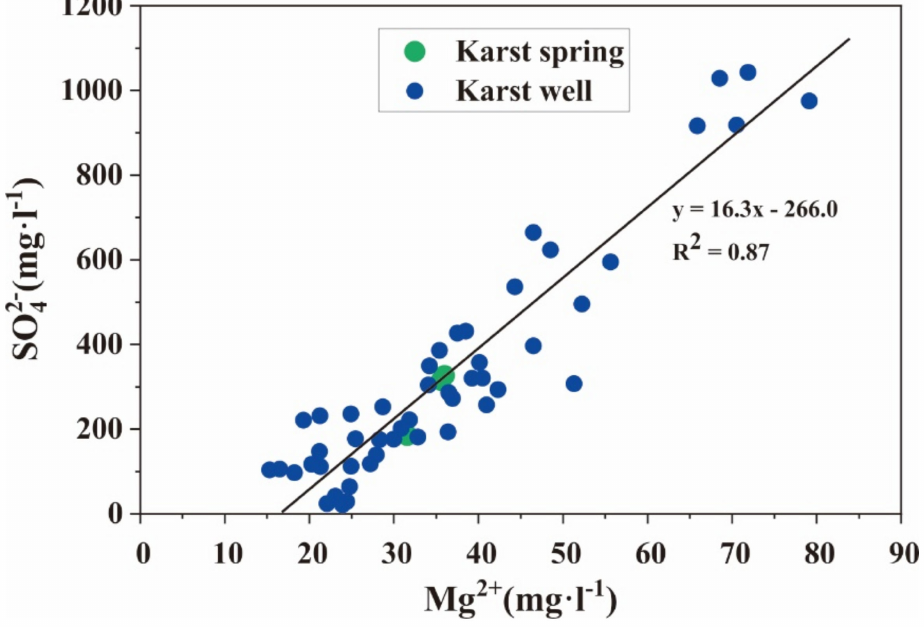
Figure 11. Relationships between SO 42 − vs. Mg 2+